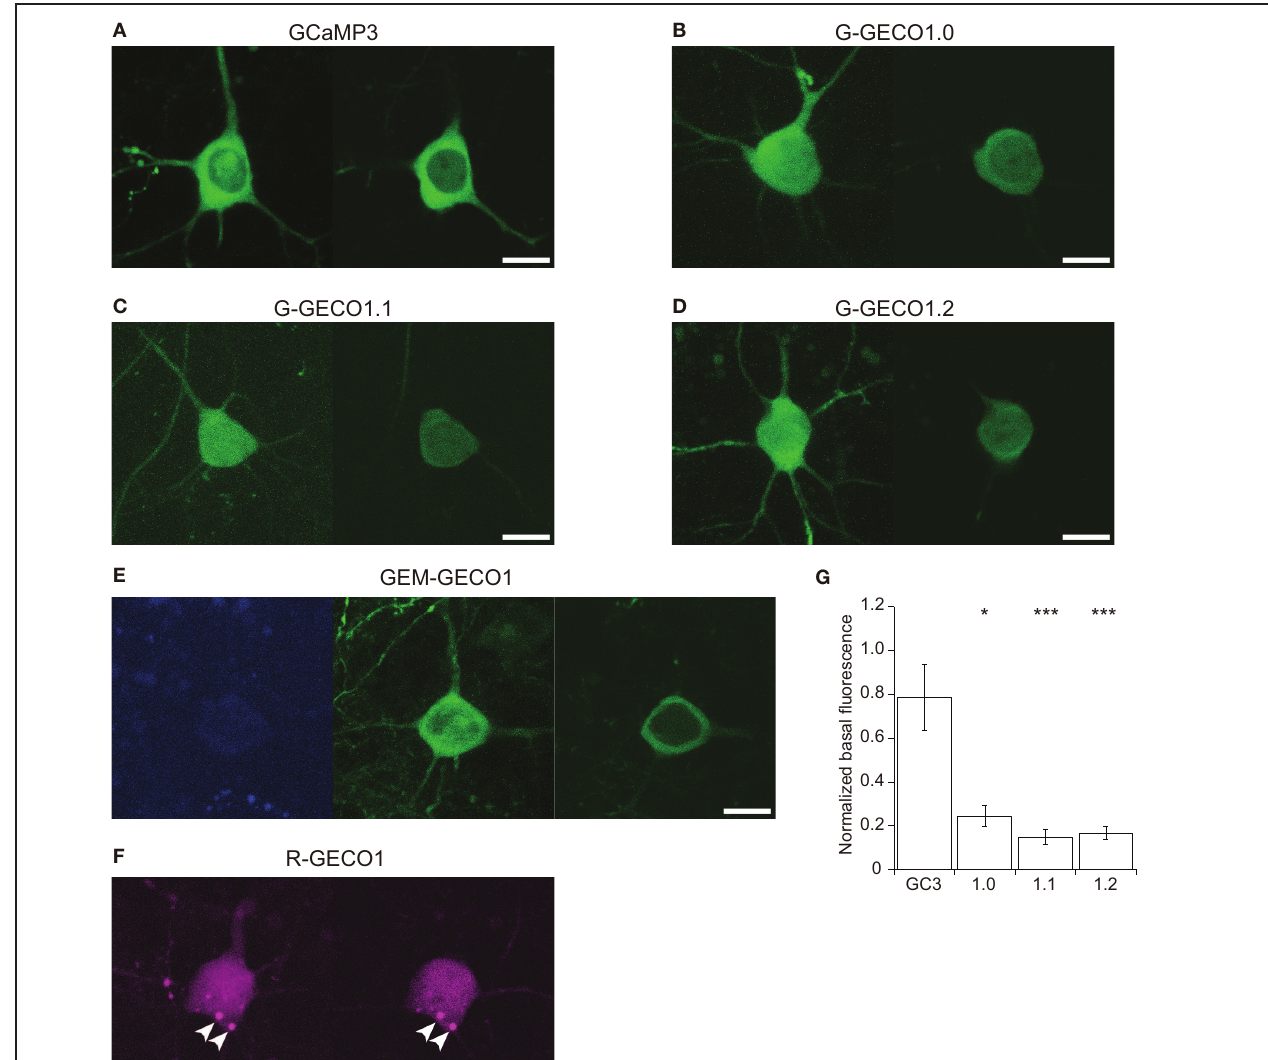
FIGURE 1 | Expression patterns of GCaMP3 and GECOs in cortical layer 2/3 pyramidal cells. (A–D) Representative expression patterns of GCaMP3 (A) G-GECO1.0 (B) G-GECO1.1 (C) G-GECO1.2 (D) . Maximum intensity projection images (left) and single z-section images containing the nucleus (right) of GECIs are shown. (E) A representative expression pattern of GEM-GECO1. A maximum intensity projection image of the blue channel (left) and a maximum intensity projection image of the green channel (center) and a single z-section of the green channel containing the nucleus (right) are shown. (F) A representative expression pattern of R-GECO1. A maximum